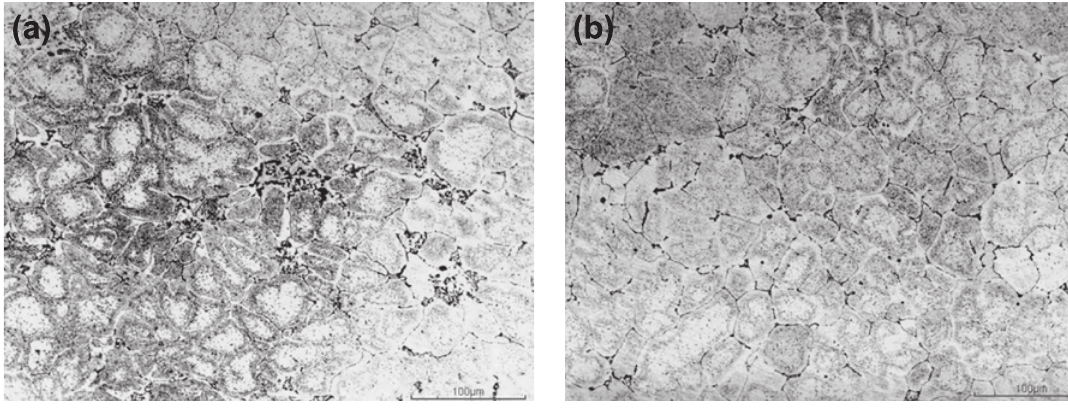
Fig. 8: Microstructures of the 7005 alloy specimens deformed at (a) 300 °C/0.0005 s − 1 and (b) 450 °C/0.0005 s − 1